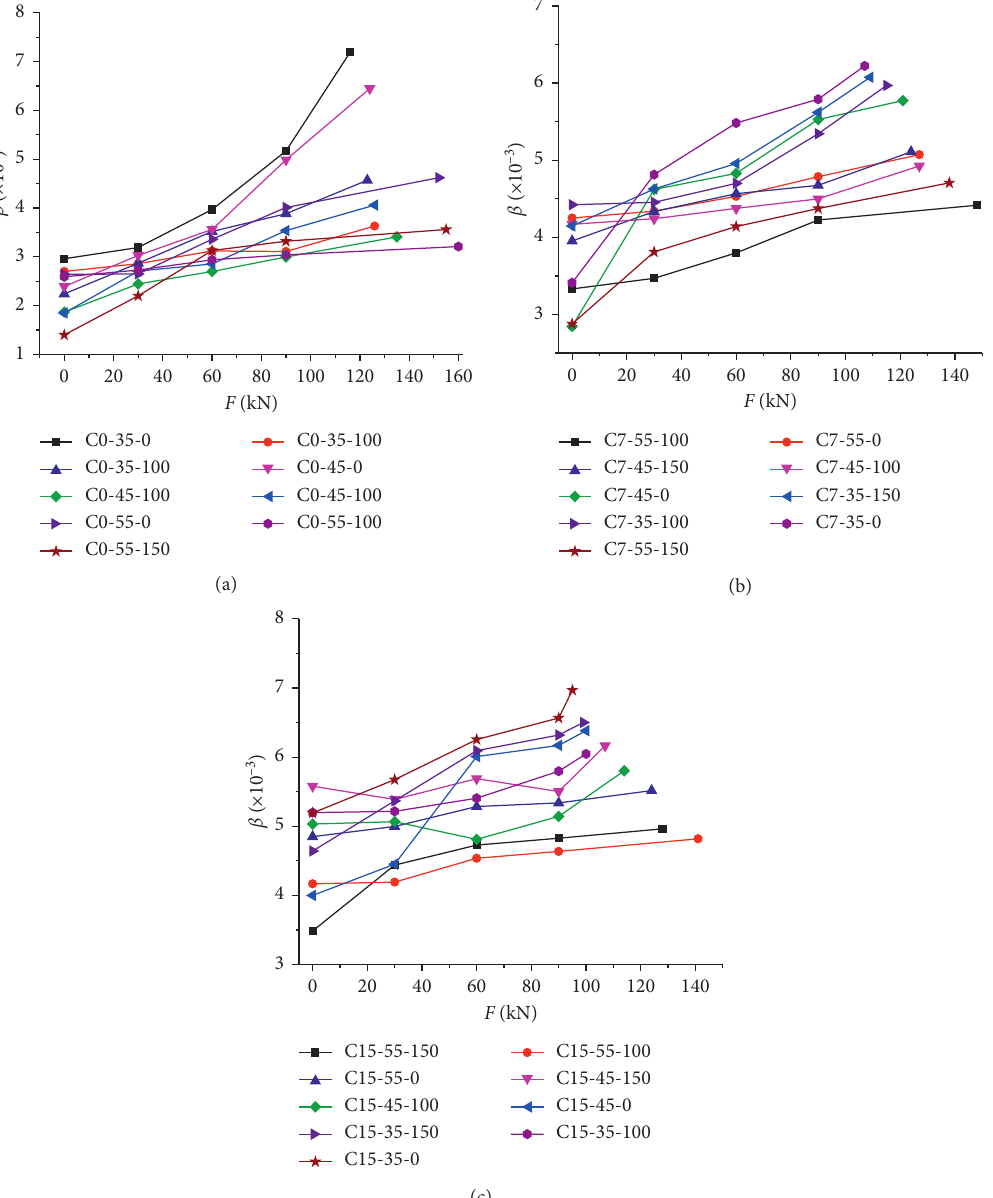
Figure 9: The changing trend of specimens’ nonlinear coefficient with putout load (a) for the specimens without corrosion; (b) for the specimens with 7% corrosion rate; and (c) for the specimens with 15% corrosion